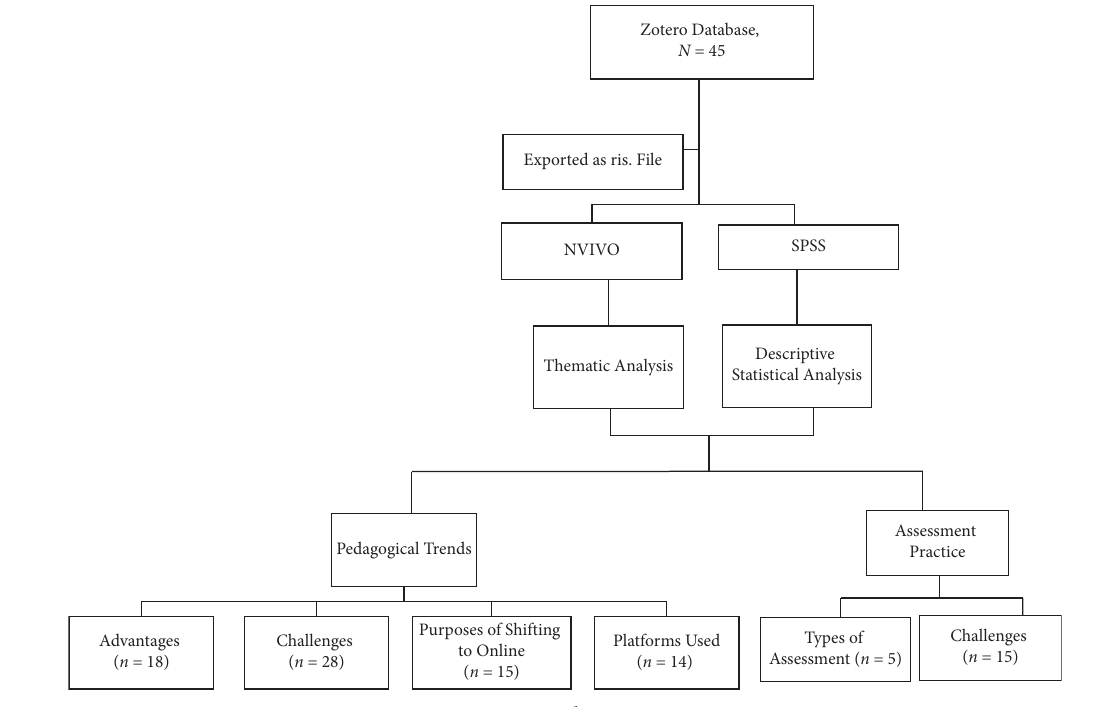
Figure 1: Analysis process. Table 1: A summary of the findings from the selected